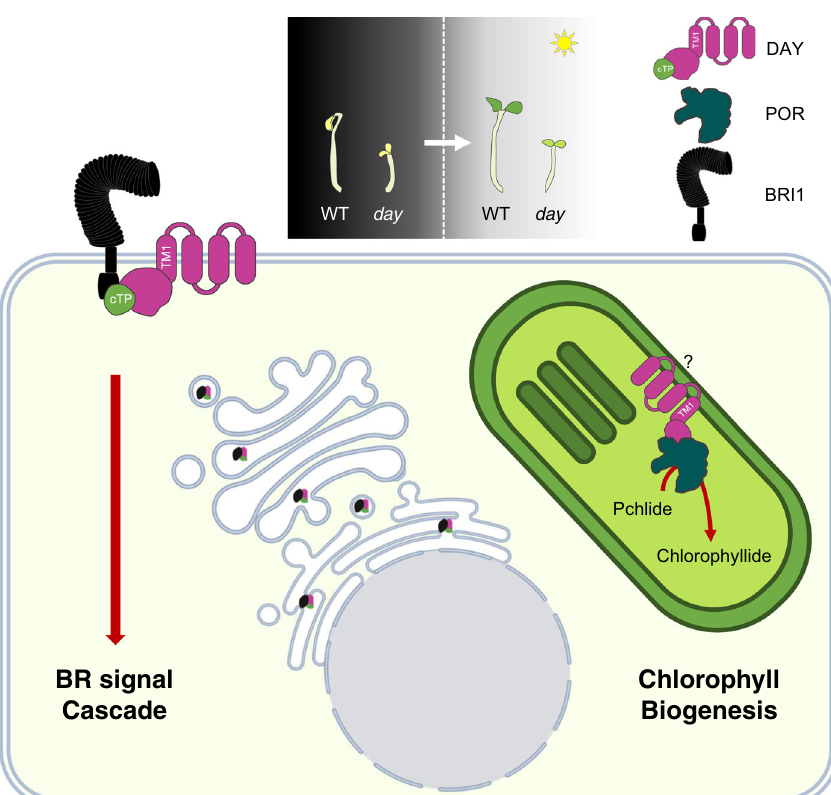
Fig. 6 A model for stabilization of BRI1 and POR by DAY in different subcellular compartments. DAY binds to and stabilizes BRI1 and POR in the endomembrane system and chloroplast, respectively. The cTP sequence is suf fi cient to transfer DAY to the inner envelope membrane of chloroplast and the fi rst transmembrane domain is required for DAY localization in ER, TGN/EE, and plasma membrane. DAY-mediated BR signaling and chlorophyll biosynthesis are essential for photomorphogenesis. The illustration of nuclear envelope-ER-Golgi is purchased from